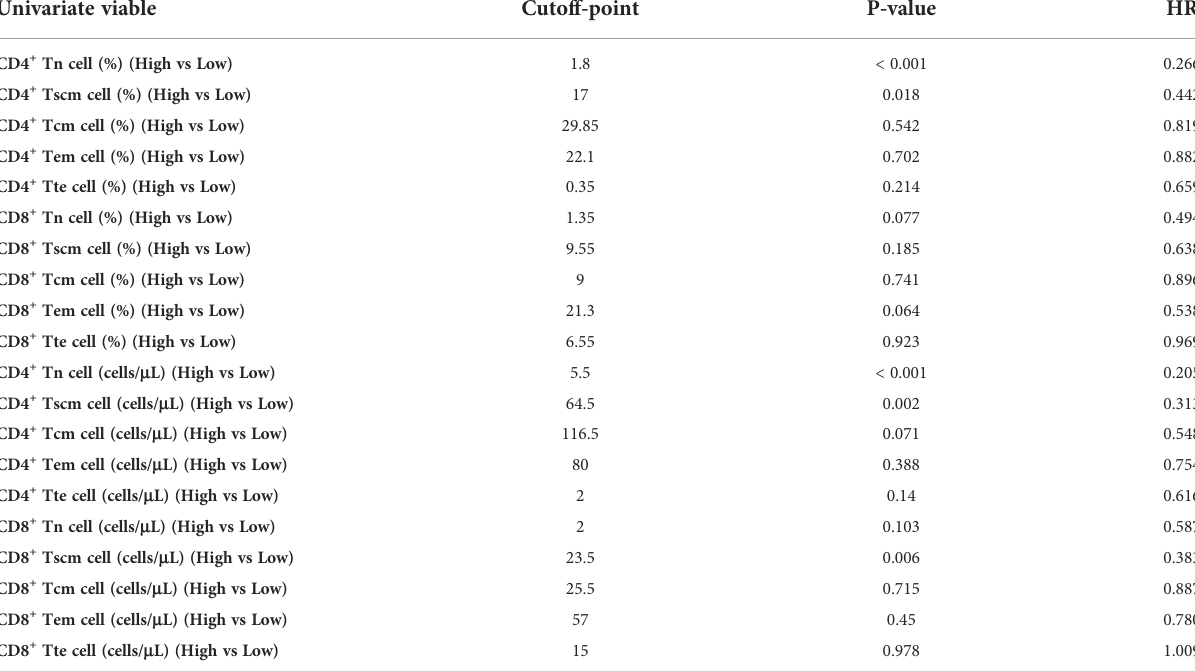
TABLE 5 Univariate analysis on PFS of aNSCLCs who received immunotherapy. Univariate viable